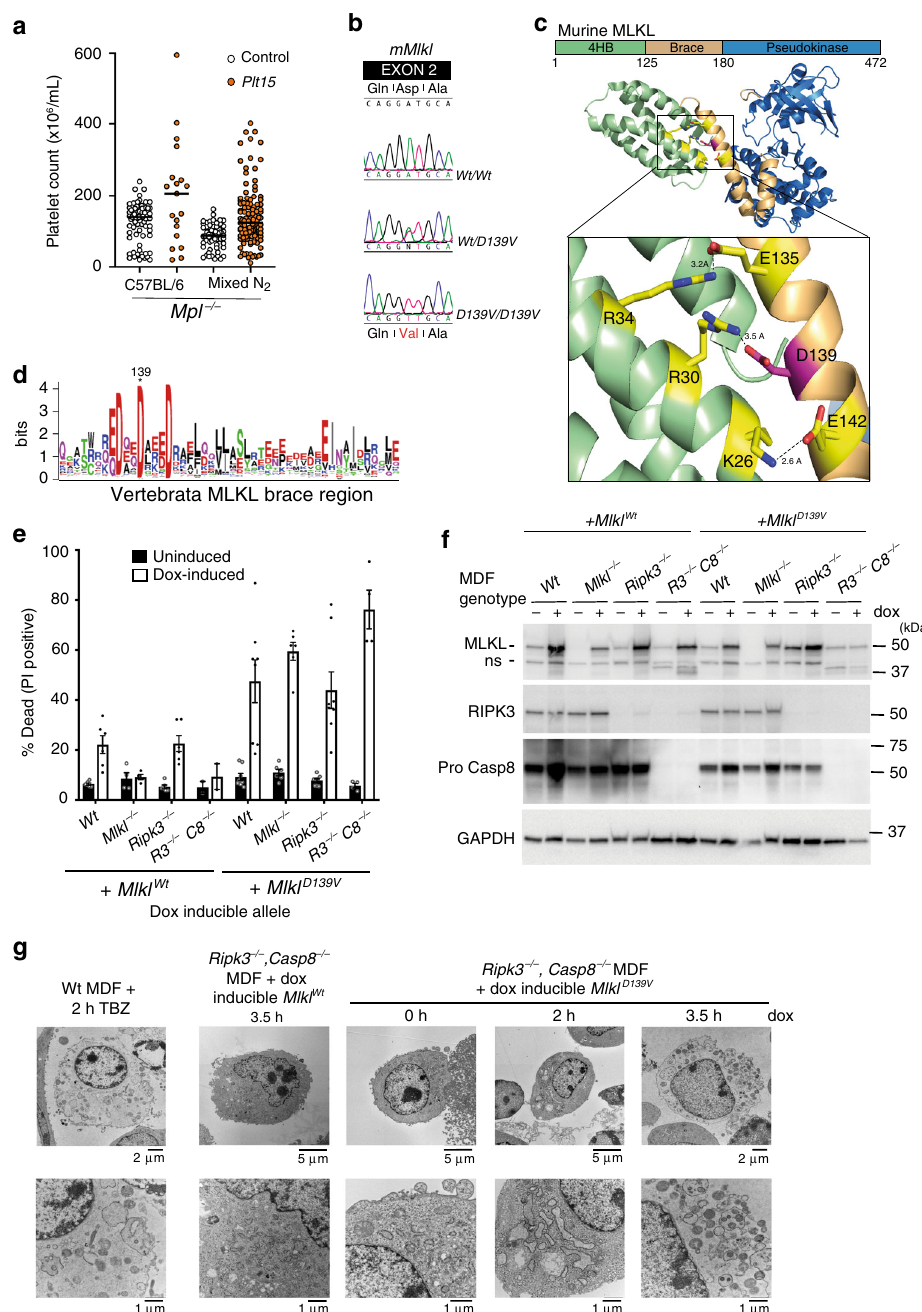
Fig. 1 Murine MLKL D139V is a constitutively active form of MLKL. a Platelet counts from Mpl − / − mice (open circles, n = 80, 60) and offspring from matings between Plt15 mice and Mpl − / − mice (closed orange circles, n = 19, 113) on a C57BL/6 or mixed C57BL/6:129/Sv background used for linkage analysis (Mixed N 2 ). b A missense mutation (D139V) in the second exon of Mlkl was identi fi ed in Plt15 mutant mice. DNA sequence shown for wild type (top), a heterozygous mutant (middle), and a homozygous mutant (bottom). c Aspartate 139 contributes to an ‘ electrostatic zipper ’ joining brace helix 1 and the 4HB α 2 helix of mouse MLKL (PDB code 4BTF) 4 . d Sequence logo of MLKL brace domain generated from multiple sequence alignment of all Vertebrata MLKL sequences (257) available on OrthoDB. e Mouse dermal fi broblasts (MDFs) of indicated genotypes were stably transduced with Mlkl Wt and Mlkl D139V and expression induced with doxycycline (dox, white bars) or not induced (black bars) for 21 h. PI-positive cells were quanti fi ed by fl ow cytometry. Means ± SEM are plotted for n = 4 – 8 experiments (a combination of biological repeats and independent experiments) for each genotype with the exception of R3 − / − C8 − / − + Mlkl Wt ( n = 2, ±range). f Western blot analysis of whole cell lysates taken 6 h post doxycycline induction. g Transmission electron micrographs of MDFs stimulated as indicated. Images selected for ( f ) and ( g ) are representative of 2 – 3 independent analyses with similar results. TBZ; TNF + Birinapant +